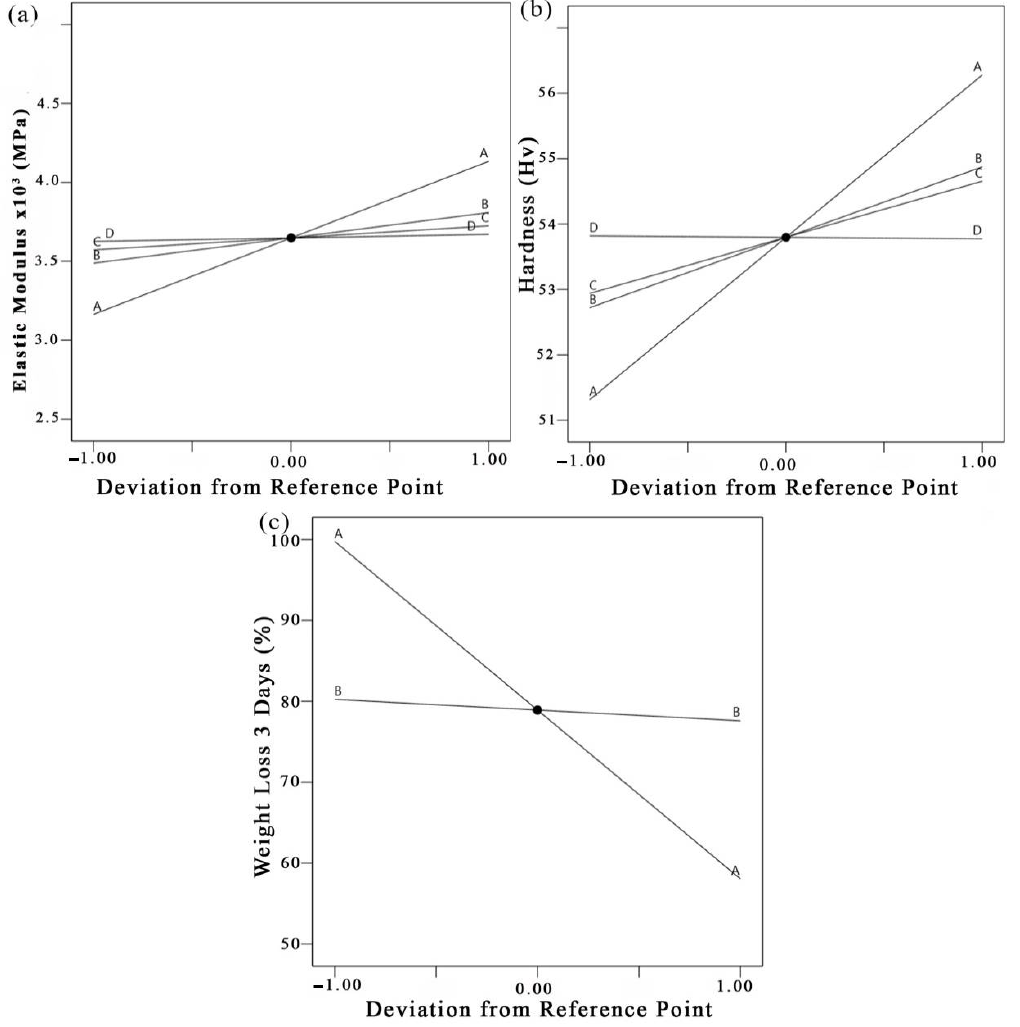
Figure 5. Perturbation plot for ( a ) elastic modulus, ( b ) hardness, and ( c ) weight loss.